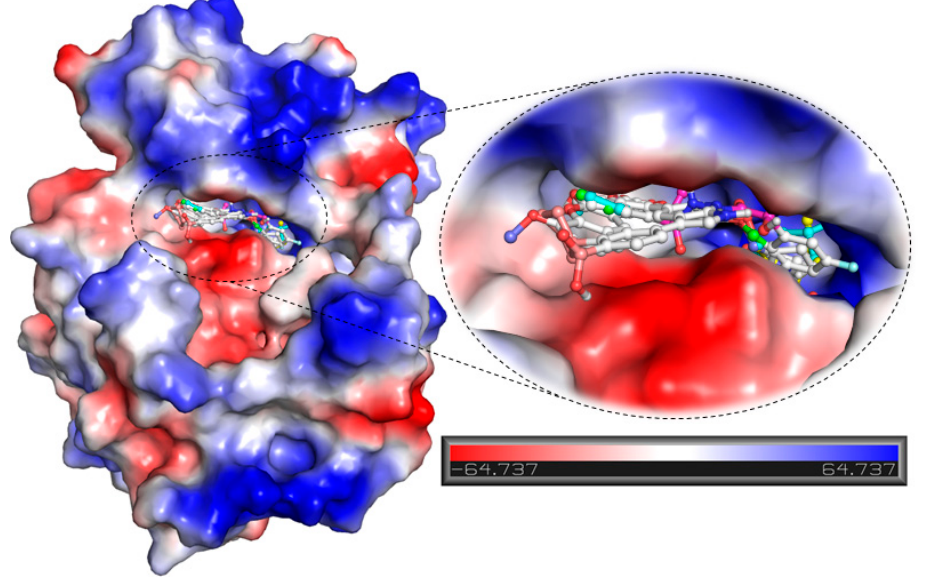
Figure 3. Potential surface representation of SGK1 in-complex with compound ZINC00319000 (green element), ZINC02106991 (cyan element), ZINC02115387 (yellow element), ZINC02121074 (blue element), EMD638683 (magenta element), and GSK650394 (red element).